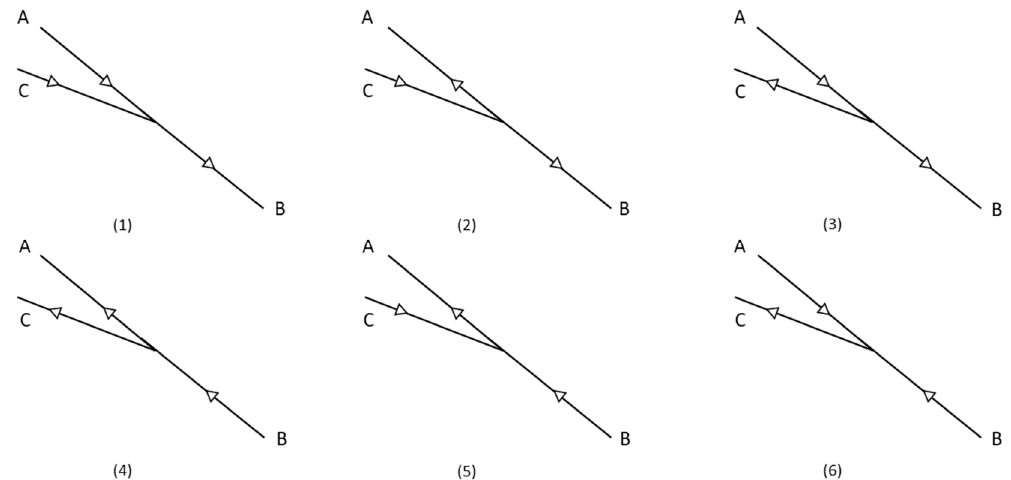
Figure 9. Physically possible flow configurations through a Y-junction.